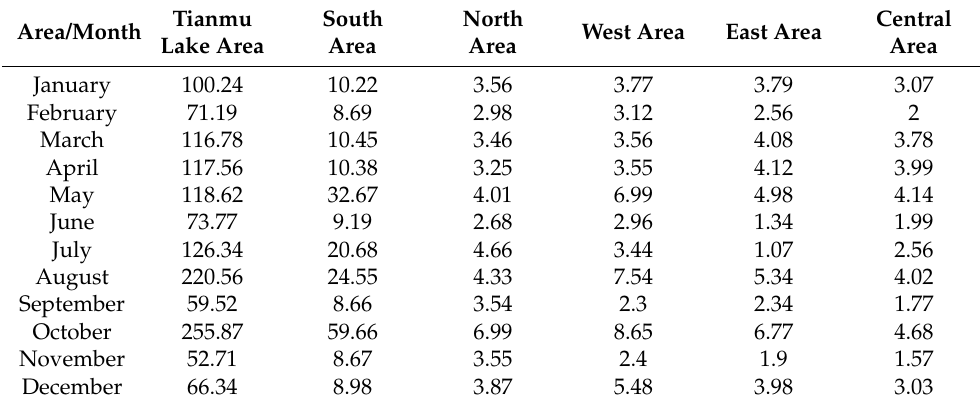
Table 8. List of tourism numbers by month in each area in Liyang,